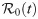
Reconstructed transmission rate Q(t) via Fine & Clakrson’s method (with a three-week shift to the left) and our estimated R0(t).